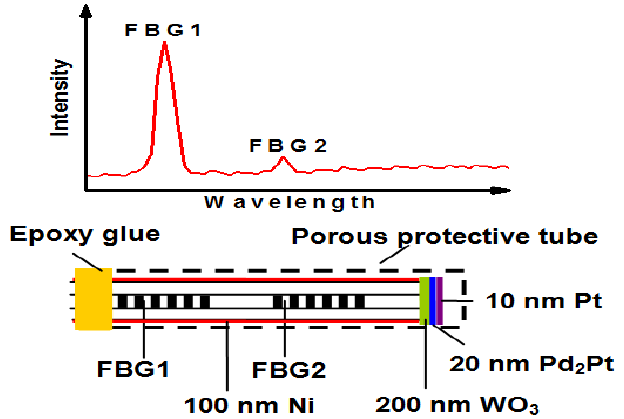
Figure 9. Configuration of high-low Bragg grating with tip coated with WO 3 -Pd 2 Pt-Pt film